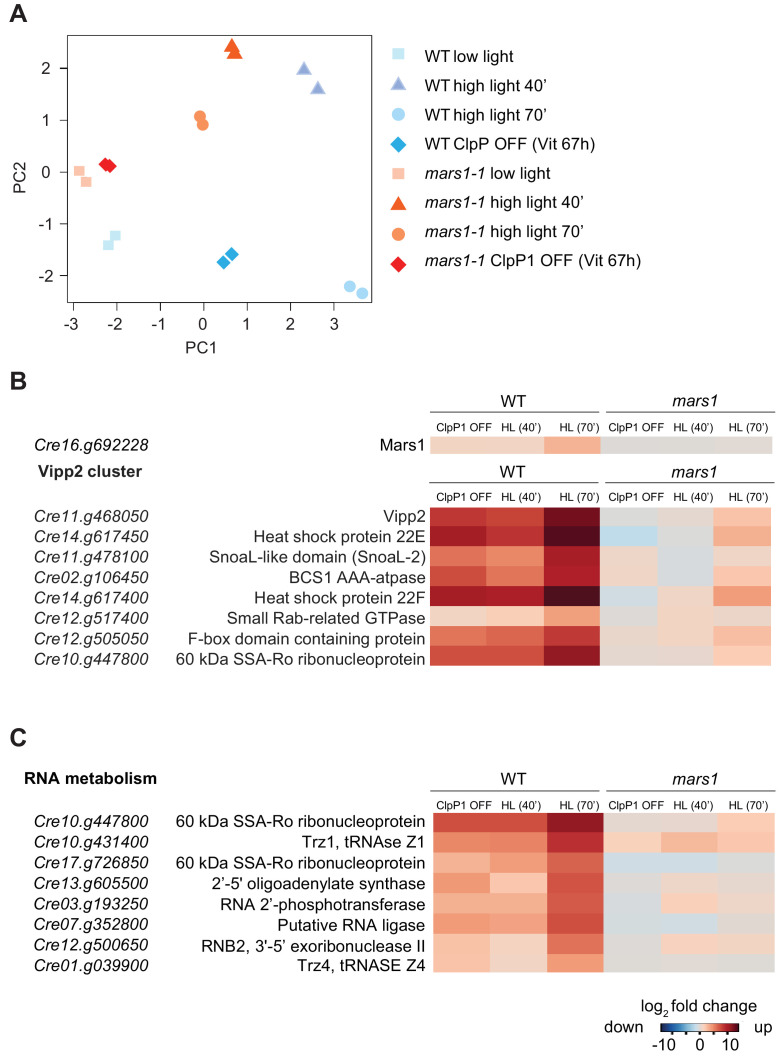
mars1 cells do not induce the cpUPR transcriptional program.(A) The multidimensional scaling plot illustrates the distance between RNA-seq samples, calculated as leading biological coefficient of variation between samples, based on the log2-fold change of top genes. WT, stressed and unstressed cells are more dispersed than those in the mars1-1 background, indicating that the MARS1 gene deletion affects both high light and ClpP1 repression responses. High light 40’=exposed to high light for 40 min; high light 70’=exposed to high light for 70 min; ClpP OFF = ClpP repression. PC1 = dimension 1; PC2 = dimension 2. (B) Heatmap comparing the VIPP2 cluster gene expression patterns in WT and mars1-1 upon HL exposure (40 and 70 min) and ClpP1 repression. MARS1 disruption abrogates the induction of almost every gene in the VIPP2 cluster. HL = high light; ClpP1 OFF = ClpP1 repression. (C) Heatmap comparing expression pattern of manually-selected genes involved in RNA metabolism in WT and mars1-1 upon HL exposure (40 and 70 min) and ClpP1 repression. MARS1 disruption impairs the induction of these genes. HL = high light.